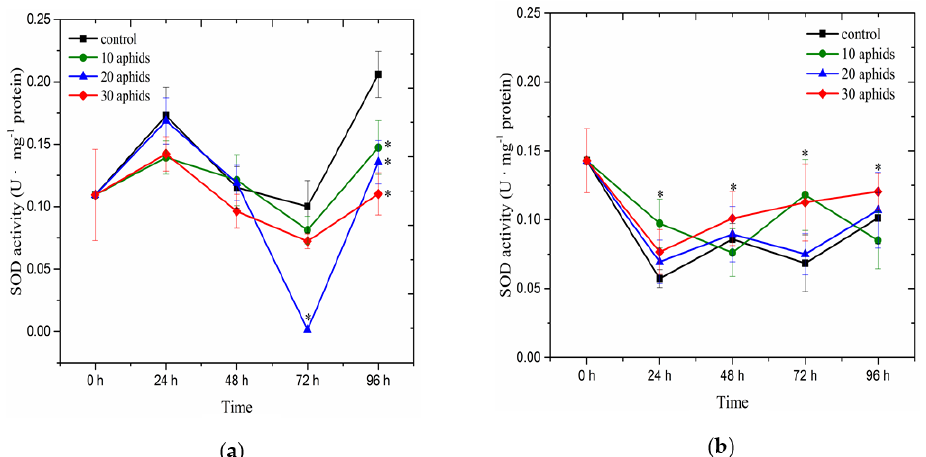
Figure 4. Superoxide dismutase activity in leaves of one- ( a ) and two-month-old plants ( b ) of Asparagus officinalis L. cv. Argenteuil infested by Brachycorynella asparagi (Mordv.) at a varied population size (10, 20, 30 aphids per plant). Values represent means and SE from three independent experiments. The data was statistically analyzed using ANOVA ( p -values at α = 0.05). In individual figures significant differences are shown using asterisks.